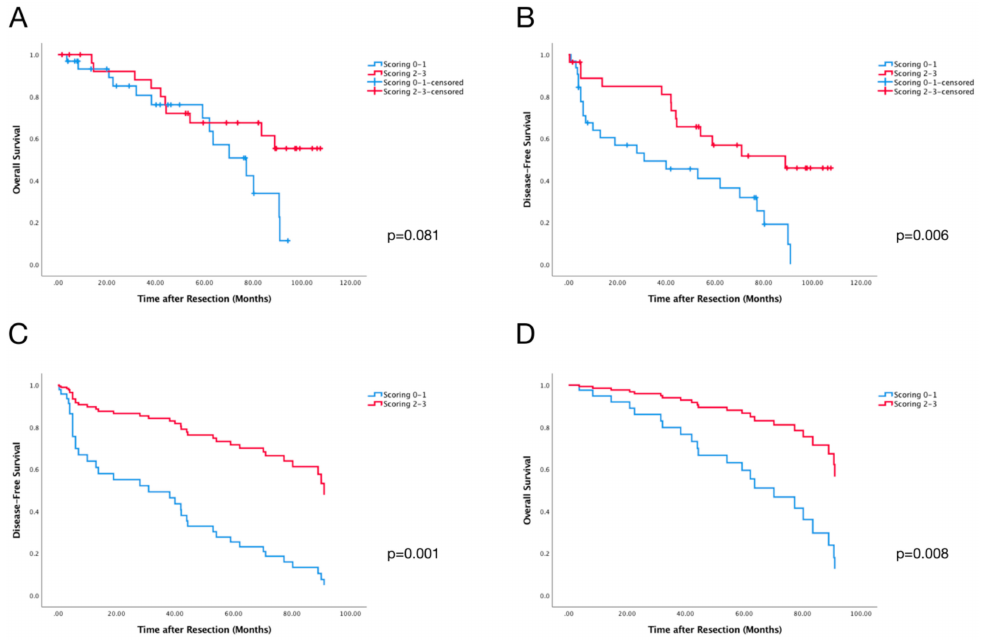
Figure 4. Kaplan-Meier Curves of Scoring on ( A ) overall survival (OS) and ( B ) disease-free survival (DFS). ( C ) Cox Regression Curves of Scoring on DFS with Collett’s Model for Selection of Covariates. ( D ) Cox Regression Curves of Scoring on OS with Collett’s Model for Selection of